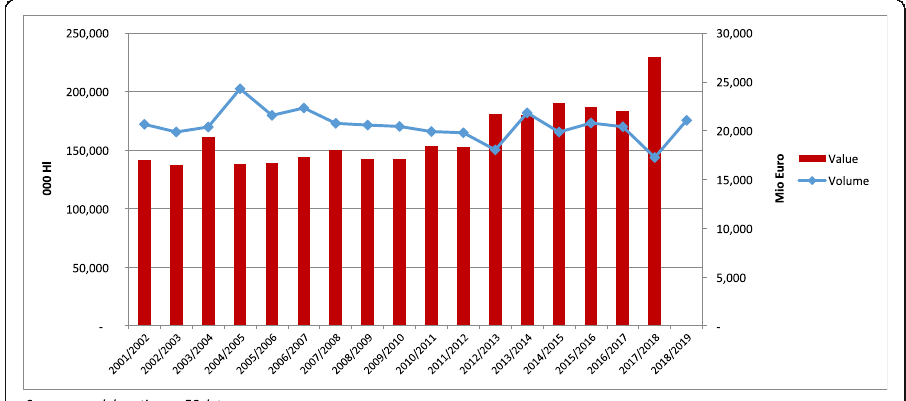
Fig. 3 EU wine ’ s production: volume and value (2001 –